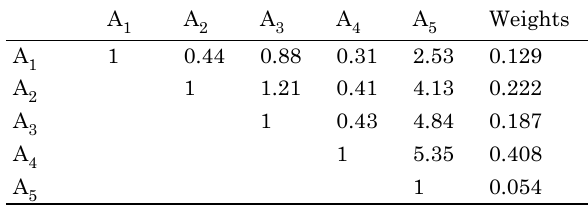
Table 7. Pairwise comparison judgment matrix of each type of exterior walls in the index of construction speed